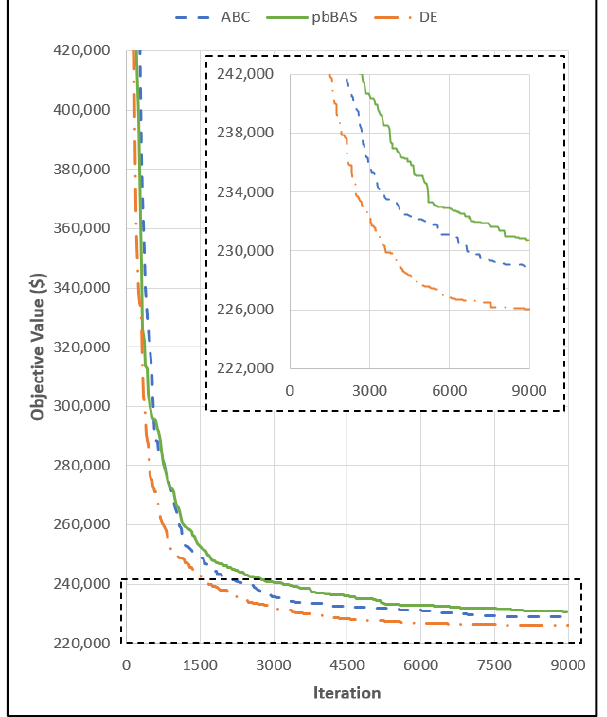
Figure 13. Design history of the sample average of the 10 runs achieved by each metaheuristic algorithm for the V-type folded plate roof problem.